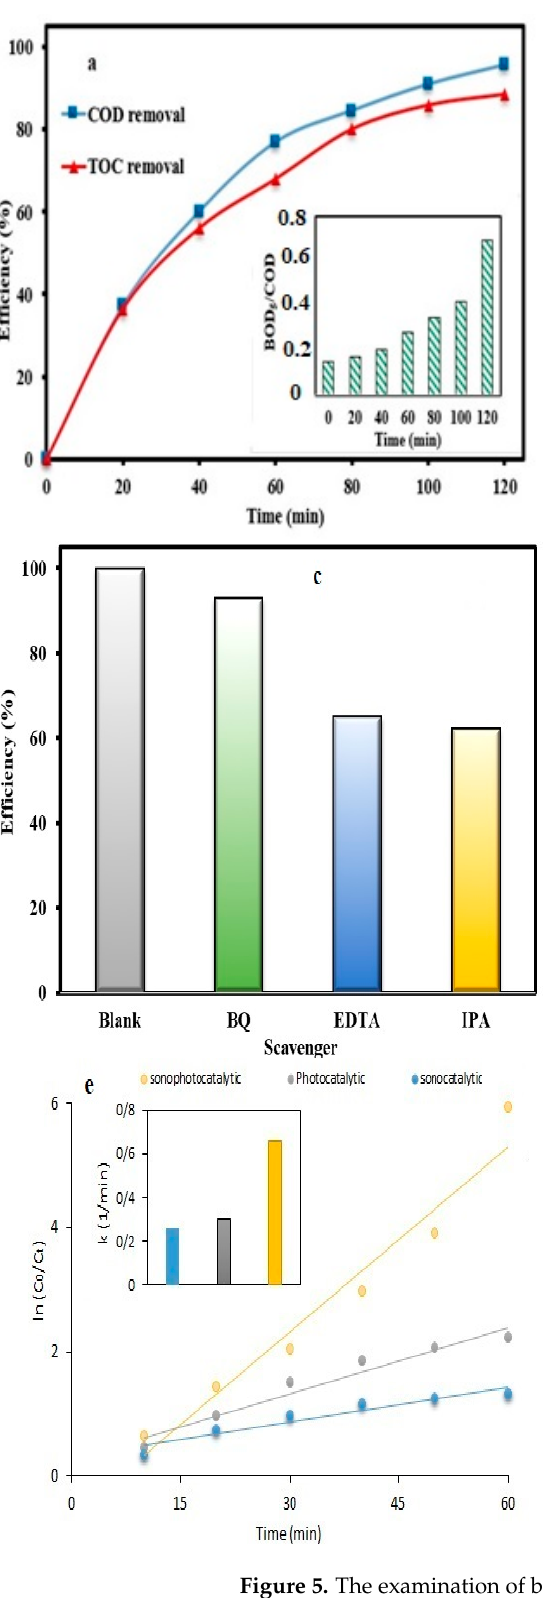
Figure 5. The examination of biodegradability and mineralization ( a ); stability and reusability of the Fe 2 O 3 /g-C 3 N 4 catalyst ( b ); scavenging effect ( c ); energy consumption during sonophotocatalytic and photocatalytic processes ( d ); pseudo-first-order kinetic modelling ( e ); and toxicity test ( f ) of the sonophotocatalytic degradation of